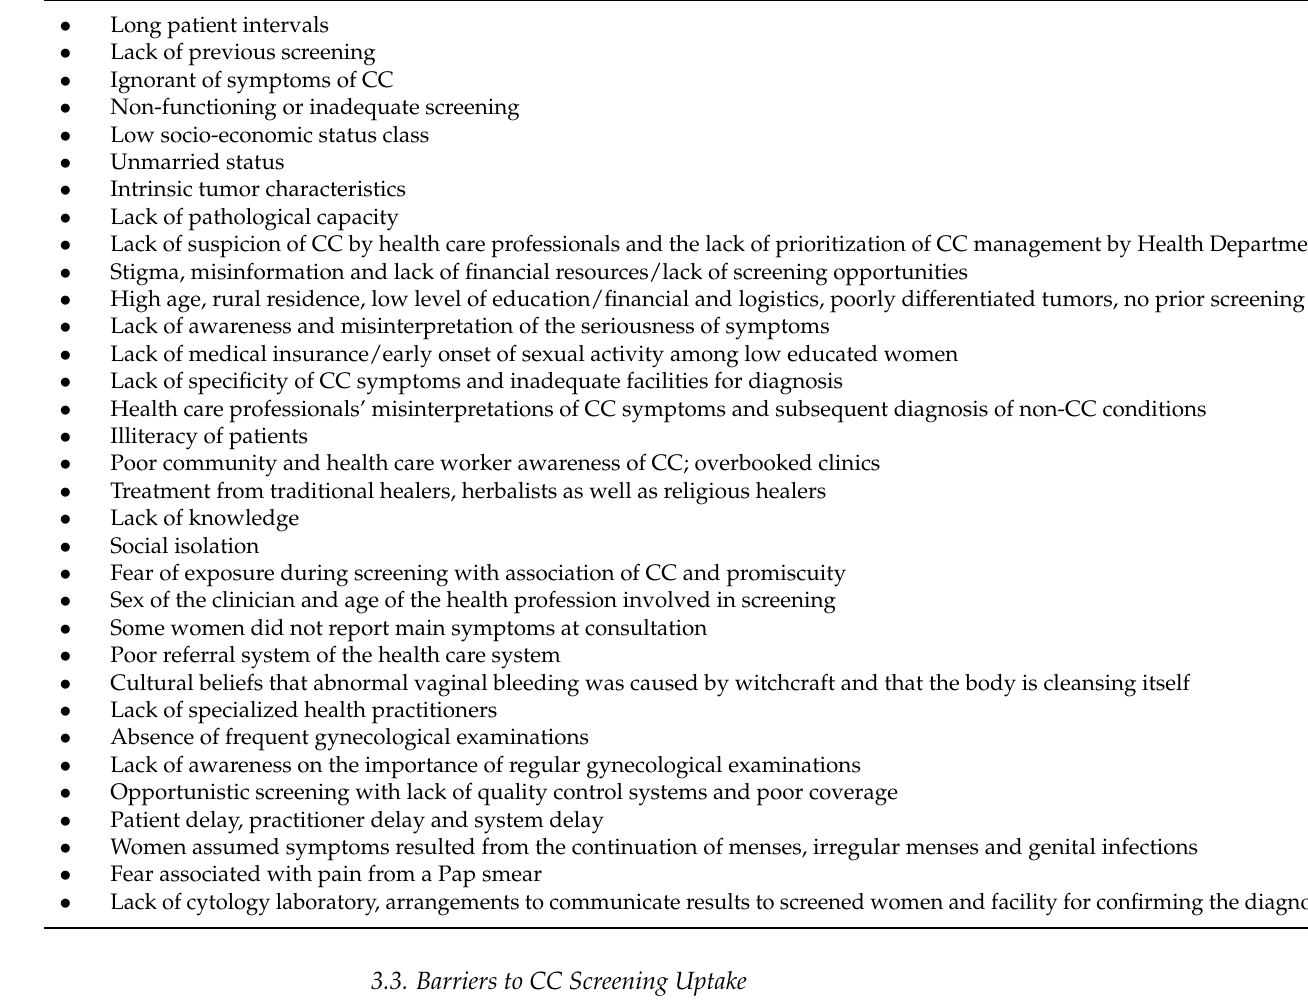
Table 2. Factors Associated with late-stage cancer presentation at